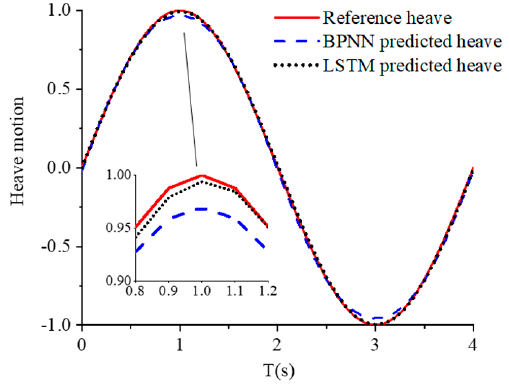
Figure 7. Prediction results of BPNN and LSTM RNN.